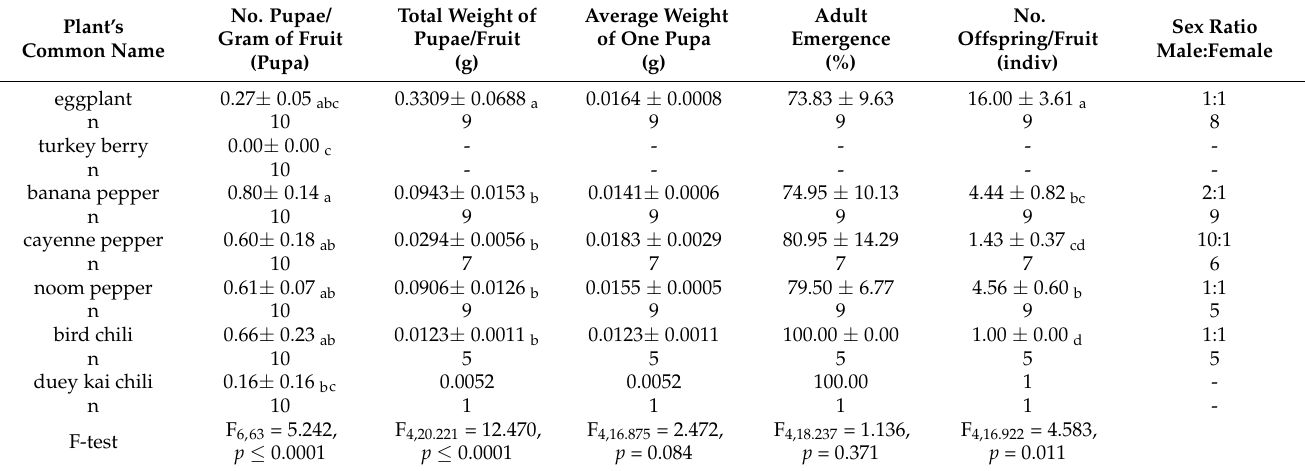
Table 3. The mean number and weight ( ± SE) of pupae and adults of Bactrocera latifrons in each plant species of all ripening stages of the choice experiment.